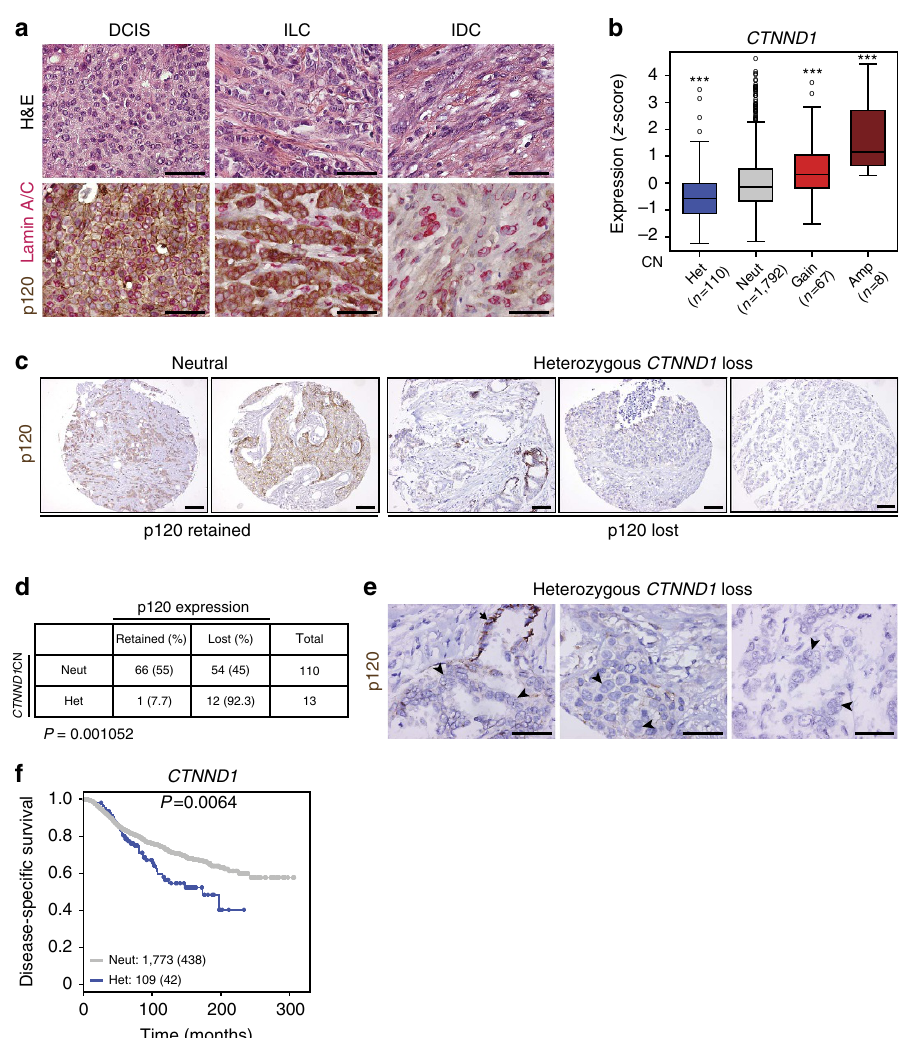
Figure 6 | Heterozygous CTNND1 loss correlates with loss of expression and decreased patient survival. ( a ) Immunohistochemistry (IHC) showing p120 and LaminA/C expression in human ductal carcinoma in situ (DCIS), invasive lobular carcinoma (ILC) and invasive ductal carcinoma (IDC). Scale bar, 50 m m. ( b ) Box plot showing the relation between CTNND1 copy-number status (CN) and p120 mRNA expression. Shown are heterozygous (het), neutral (neut), gain and amplified (amp) CN status. Statistical significance was determined using pair-wise Tukey’s testing with the neutral copy-number group. *** P o 0.001. ( c )Tissue micro-array (TMA) cores of human breast cancer were stained and scored for p120. Shown are representative images of tumours neutral and heterozygous for CTNND1 that were scored as positive (retained) or negative (lost) for p120 protein expression. Scale bar, 100 m m. ( d ) Quantification of p120 expression correlated to CTNND1 copy number (CN) of TMA cores of human mammary carcinomas. Significance was determined using the Fisher’s exact test. ( e ) IHC showing p120 expression in human breast carcinomas with heterozygous genomic loss of CTNND1 . Note the abnormal nuclear morphology in p120-deficient tumour cells (arrowheads) compared with p120 expressing cells (arrow). Scale bar, 50 m m. ( f ) Kaplan–Meier curve showing disease-specific survival of breast cancer patients displaying neutral CTNND1 CN (grey; n ¼ 1,773) or heterozygous loss of CTNND1 (blue; n ¼ 109). Statistical significance was determined using the log-rank test. Censored events are shown as dots and depicted between